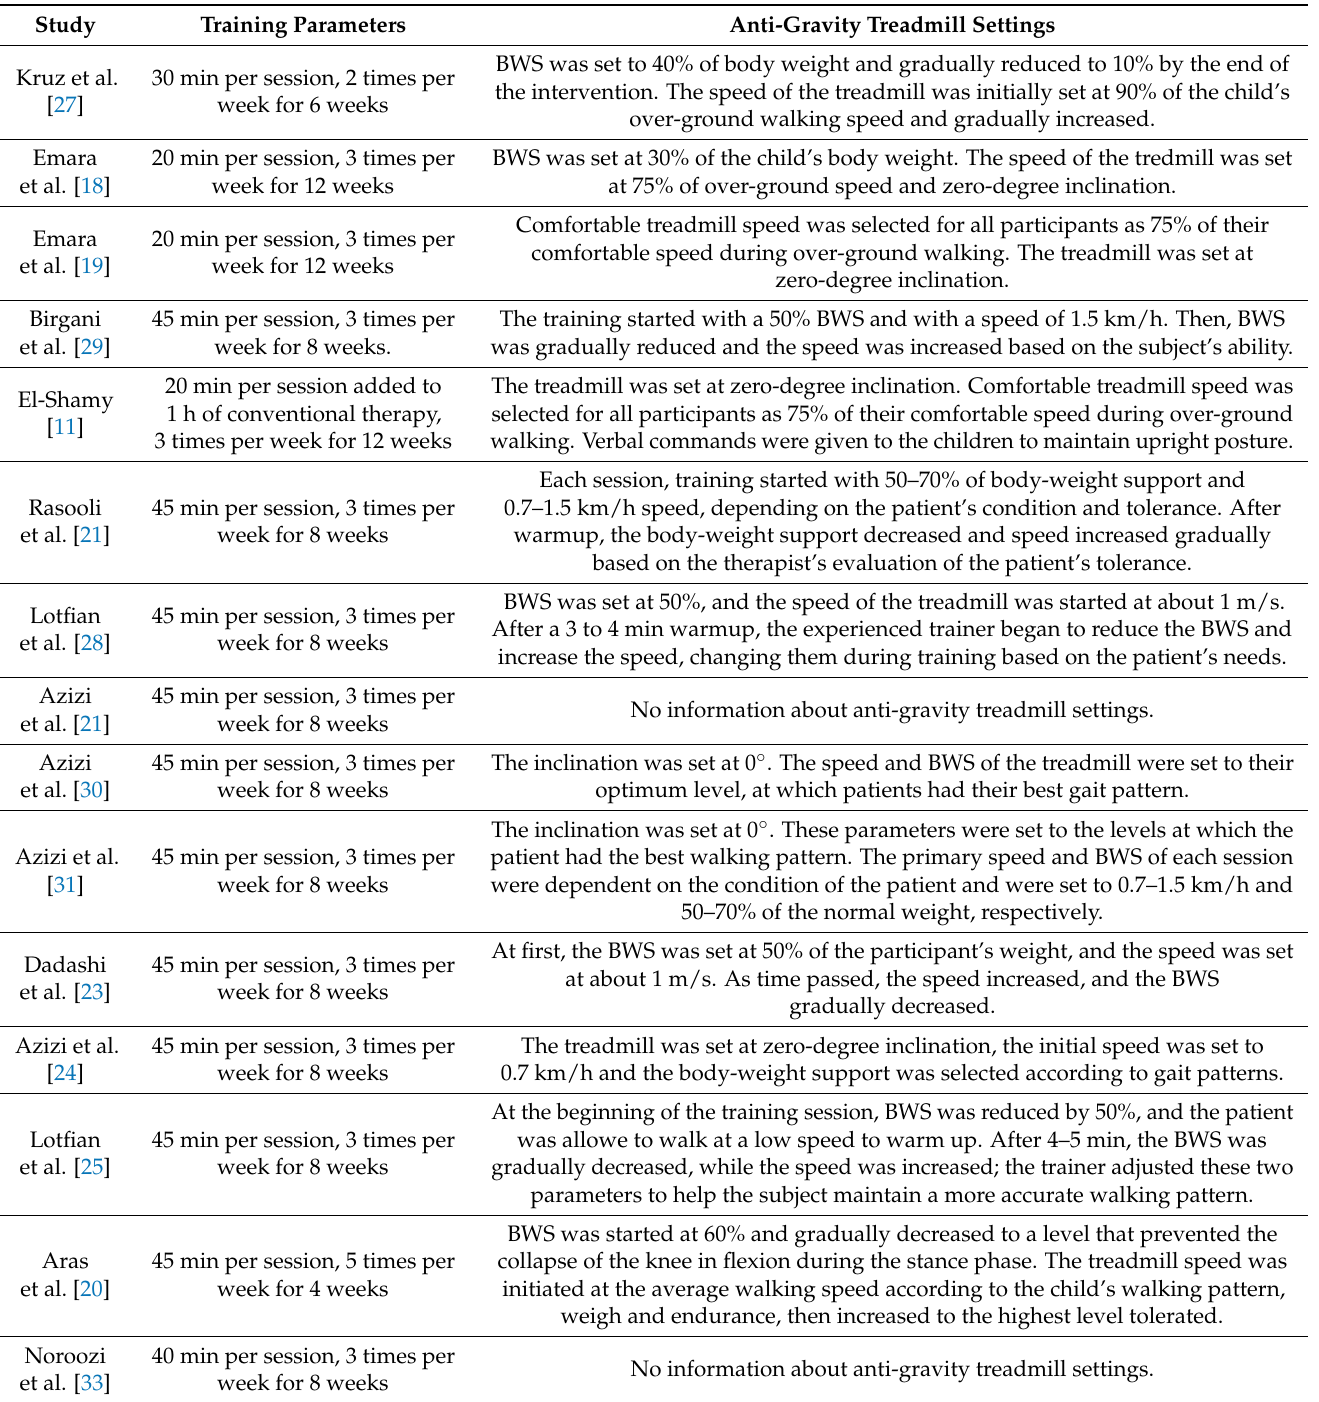
Table 3. Summary of training parameters and